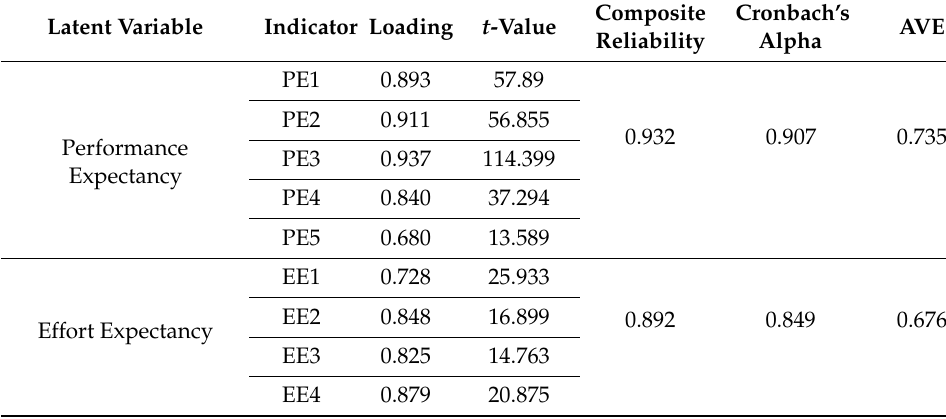
Table 4. Results of loading factor, validity, and